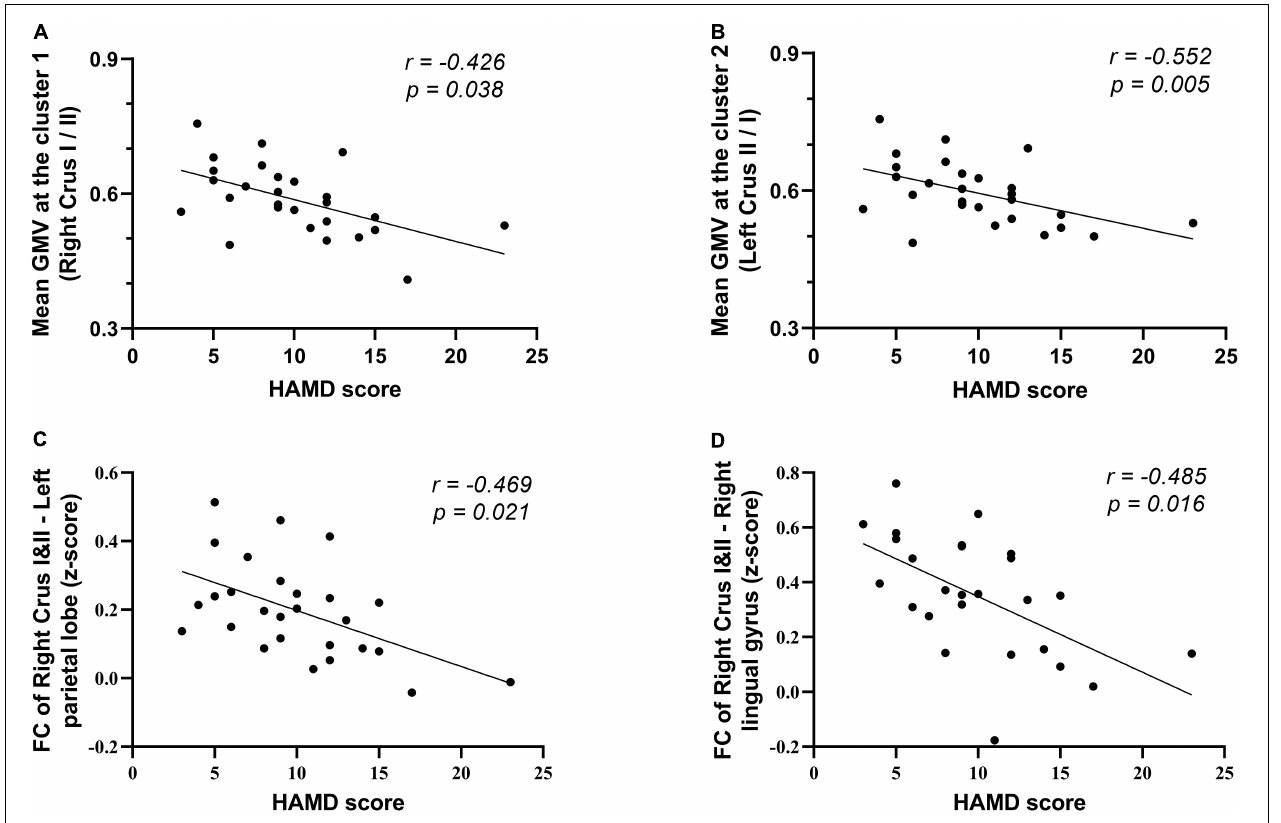
FIGURE 4 | Correlation of altered GMV and FC with the clinical characteristics in the patients with SSD. (A,B) Correlation of the mean GMV of two surviving cluster in suit VBM analysis with HAMD score. (C,D) Correlation of the FC between the ROI (located on the right crura I and II) and left parietal lobe, right lingual gyrus with HAMD score. Scatterplots for only the significant correlations ( p < 0.05) are shown here. HAMD, Hamilton Depression